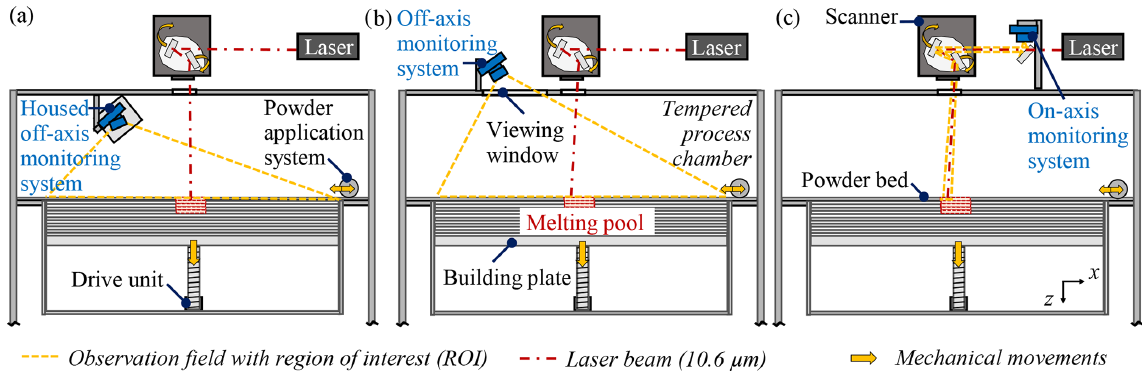
Figure 1. Positioning of monitoring systems: (a) off-axis, inside, (b) off-axis, outside, and (c) on-axis, outside the process chamber (Lerchen et al.,